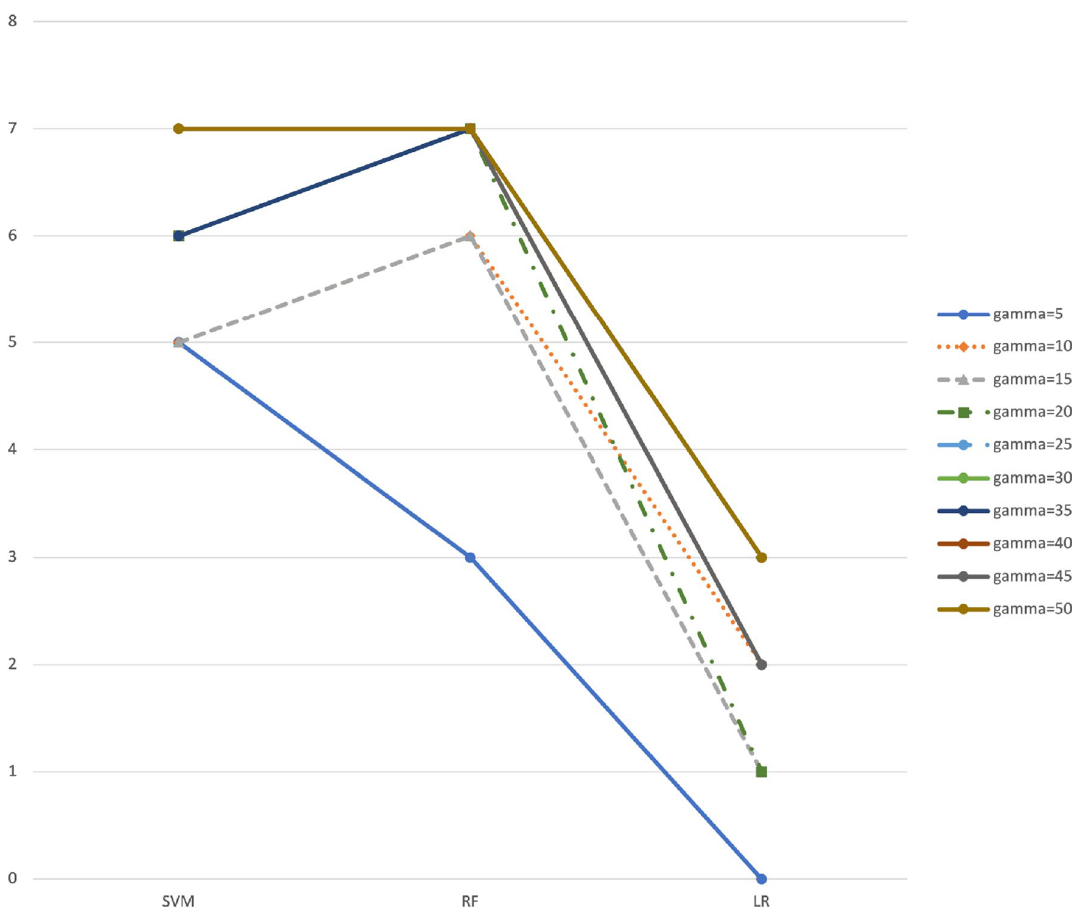
Figure 5. Graphic representation of the information in Table 4, by type of classifier, for the different values of γ